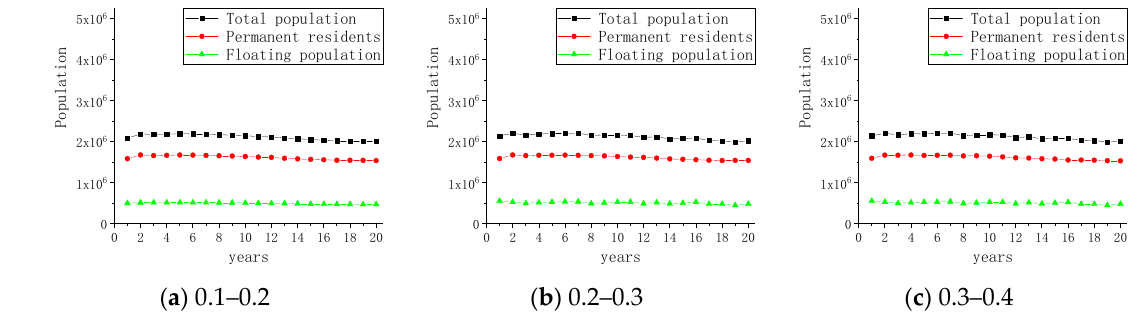
Figure 16. Population with increased coverage of safety facilities.